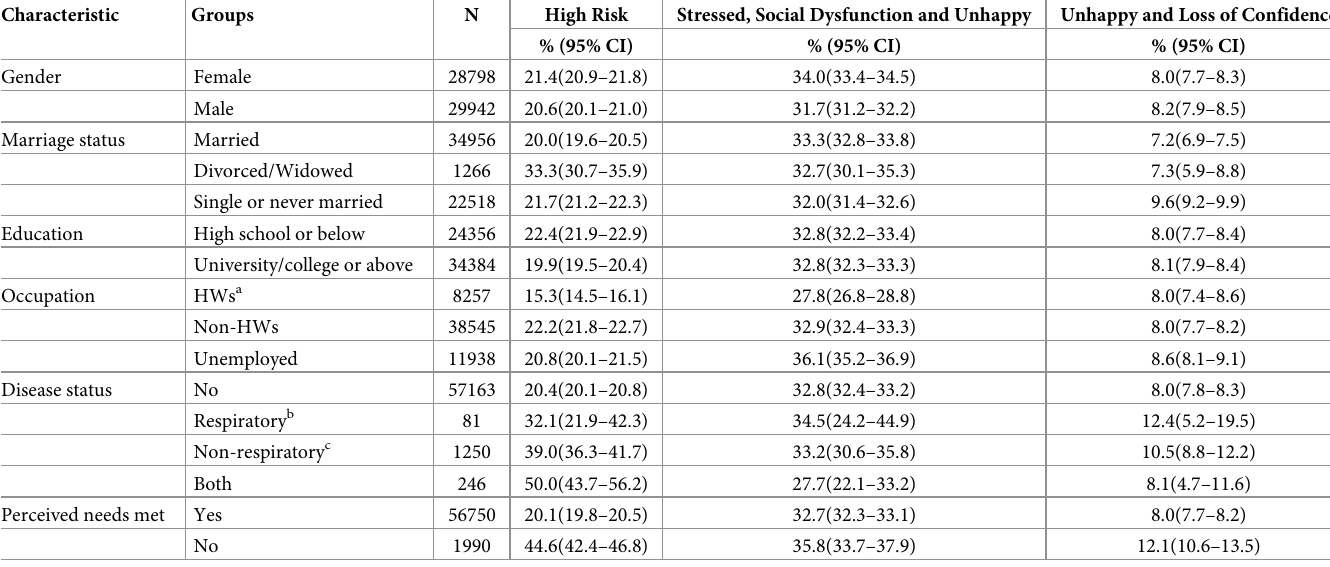
Table 2. Prevalence of mental health problems by characteristic—After easing COVID-19 restrictions (N =